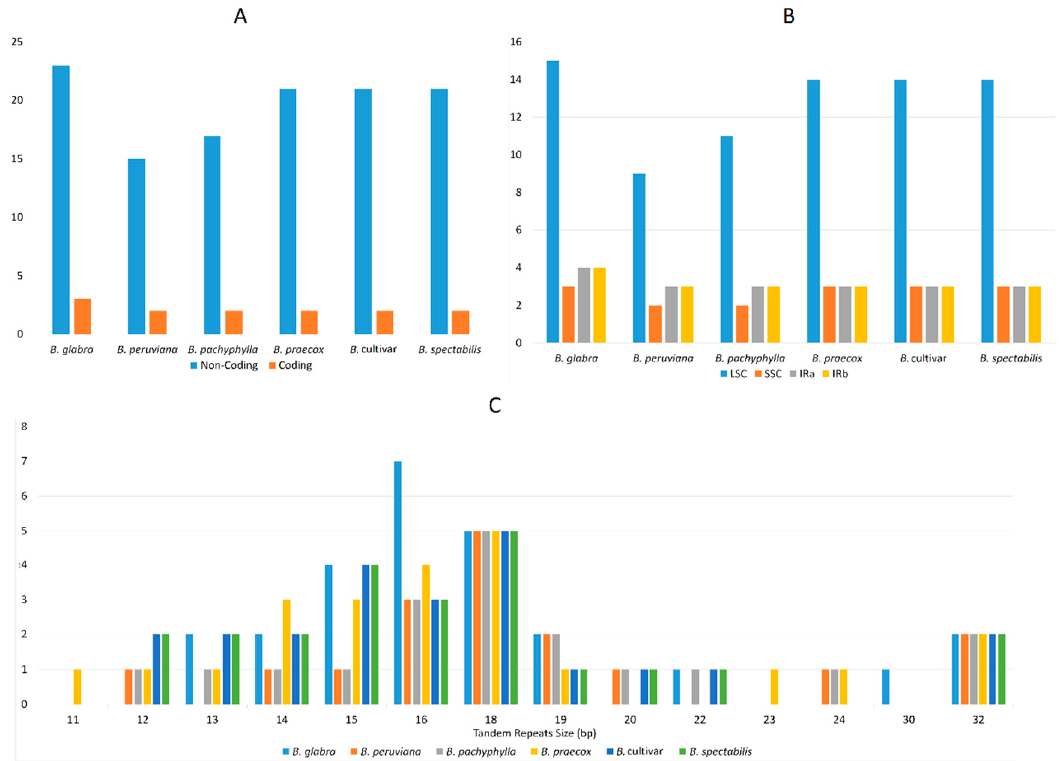
Figure 4. Tandem repeat analysis in six Bougainvillea cp genomes. ( A ) Frequency of tandem repeats in the non-coding and coding regions of six cp genomes. ( B ) Distributions of the detected tandem repeats in LSC, SSC, and IR regions. ( C ) Lengths of the identified tandem repeats in all six Bougainvillea cp genomes.